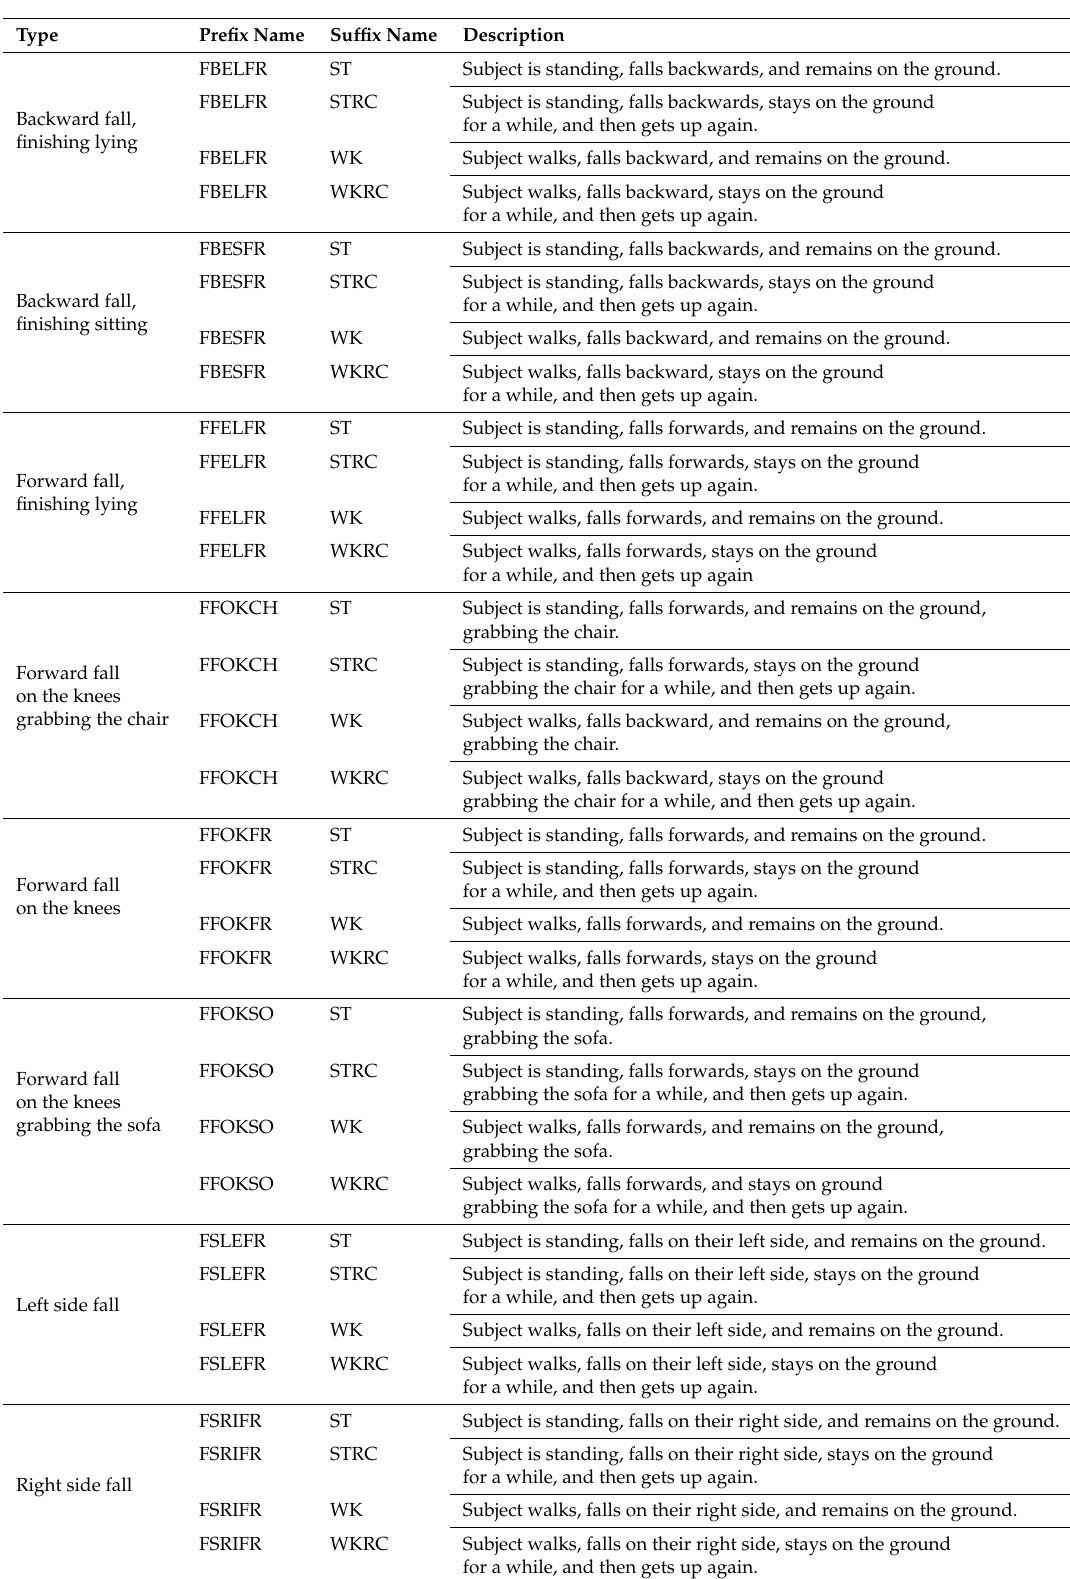
Table 1. Protocol of fall detection